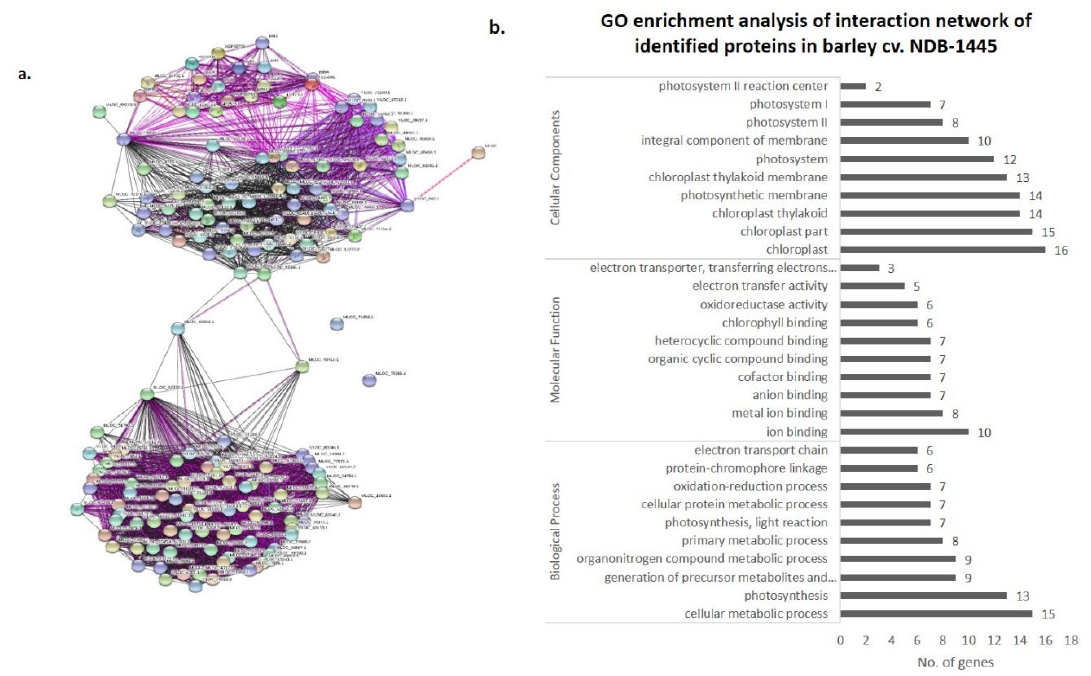
Figure 8. Protein interaction network analysis of differentially expressed proteins (including primary interactors) in barley cv. NDB-1445 using STRING v.11.0. ( a ). Network was constructed at an interaction score cut off value of ≥ 0.700 with maximum number of primary interactors set to 500, including experimental evidence (pink lines), gene fusion (red lines), and co-expression (black lines). ( b ) Graph showing GO enrichment analysis of interaction network representing the no. of genes classified in respective GO categories (FDR corrected p value ≤ 0.01).